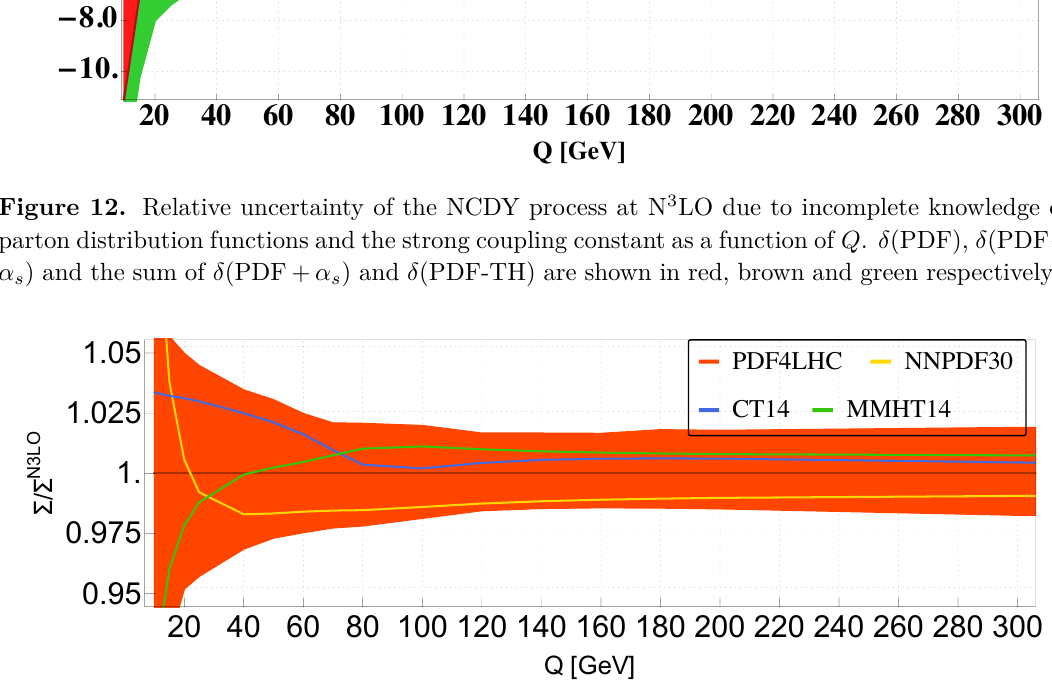
based on the individual PDF sets are contained within this band and that their spread